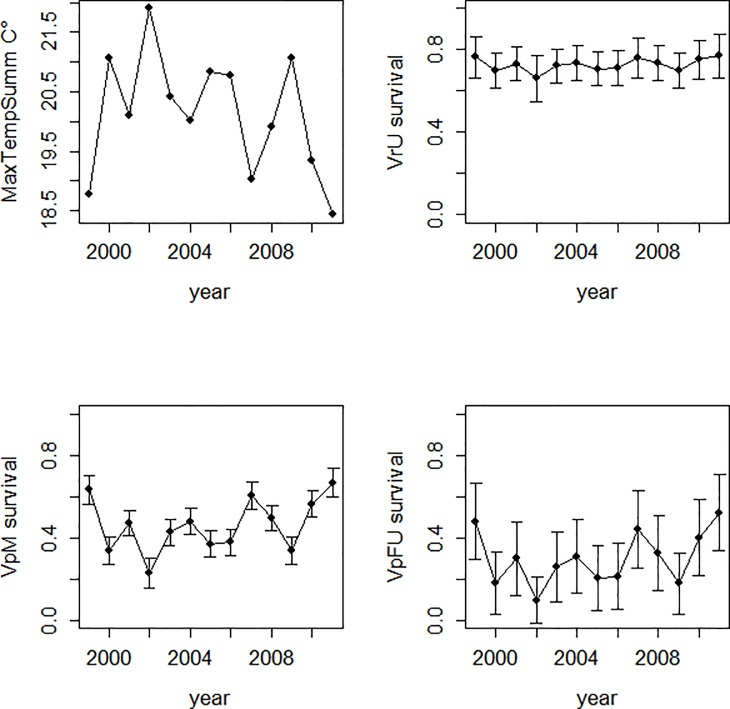
Time varying survival parameters and their covariate (MaxTempSumm).The value plotted over year n (n = 1999–2011) is survival over the year beginning with the capture event of year n to year n+1. VrU = V. regulus in unlogged; VpM = V. pumilus males; VpFU = V. pumilus females in unlogged. Note that survival values are averages over modelled estimates assuming covariation with the weather covariates.